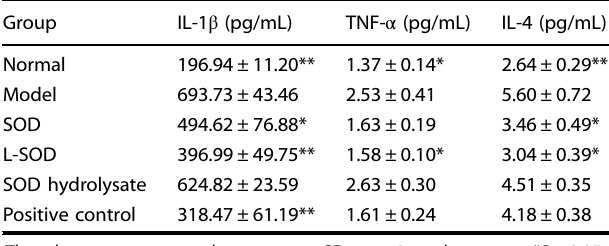
The data are presented as mean± SD, n = 6 each group. * P < 0.05, ** P <0.01 vs. model group